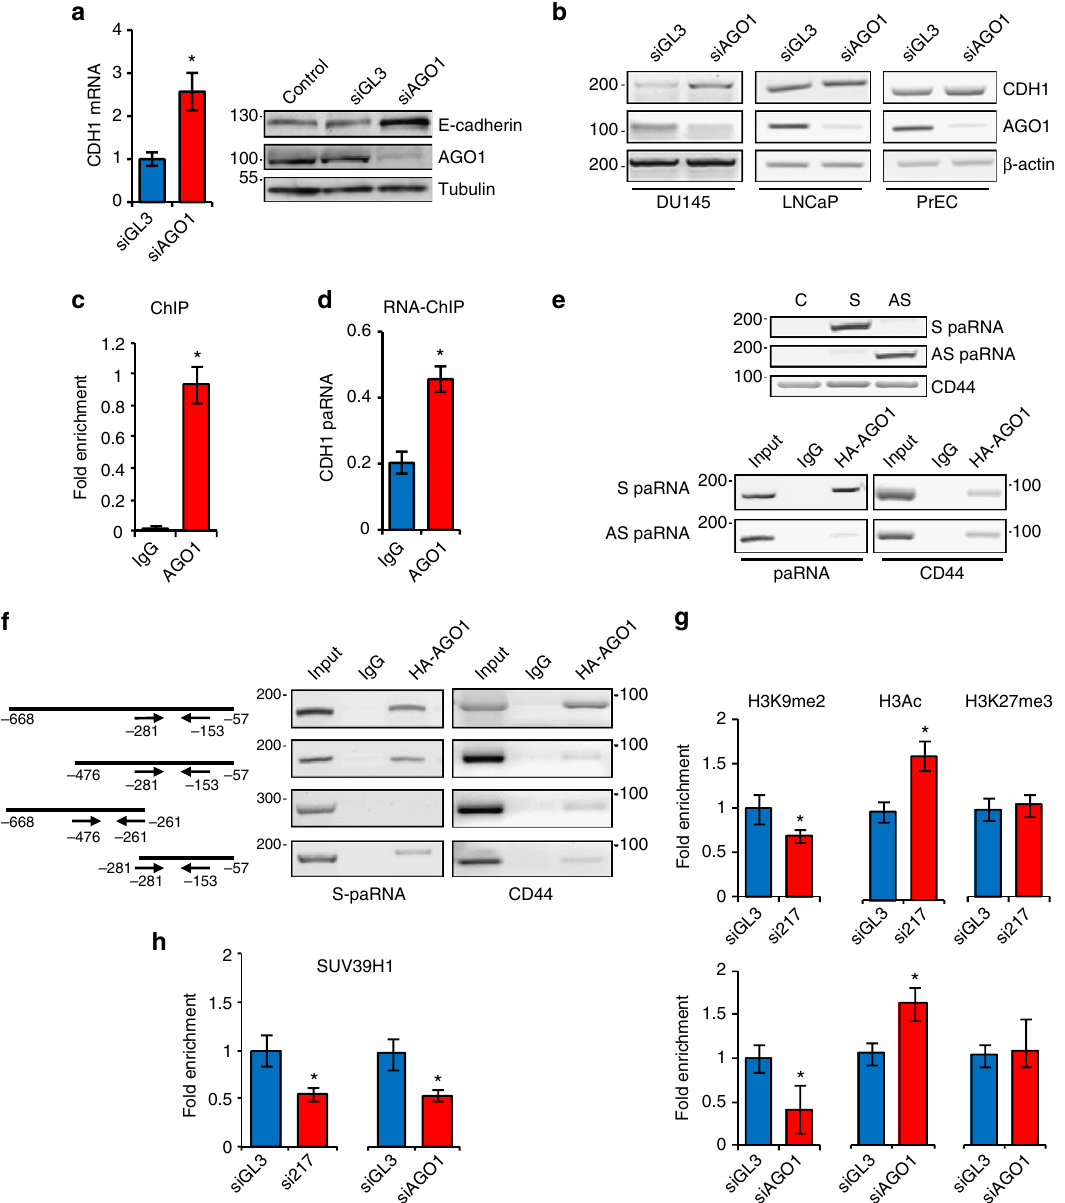
Figure 3 | Argonaute 1 and promoter-associated RNA coordinate CDH1 gene silencing. ( a ) CDH1 mRNA (left) and protein levels (right) in PC3 cells transfected for 72h with siAGO1 or siGL3. ( b ) CDH1 mRNA in DU145, LNCaP and PrECs transfected with siAGO1 or siGL3 and collected after 72h. ( c ) AGO1 binding to the CDH1 promoter determined by ChIP (primers F-281/R-139). ( d ) Binding of AGO1 to S-paRNA determined by RNA-ChIP. ( e ) Expression of S and AS-paRNA (top) and binding to AGO1 (bottom) determined by RIP in PC3 cells transfected with paRNA and AGO1 expression vectors. CD44 was used as positive control for AGO1-bound mRNA. ( f ) Binding of truncated S-paRNA transcripts to AGO1 determined by RIP. Arrows, forward and reverse primer sets for each transcript. ( g ) Histone mark modifications at the CDH1 promoter in PC3 cells transfected with si217 (top) or siAGO1 (bottom) and control siGL3. ( h ) Binding of SUV39H1 to the CDH1 promoter in PC3 cells transfected with si217 (left) or siAGO1 (right) and siGL3. Data are mean ± s.d. of three independent determinations. Student’s t -test was used for P value assessment. * P o